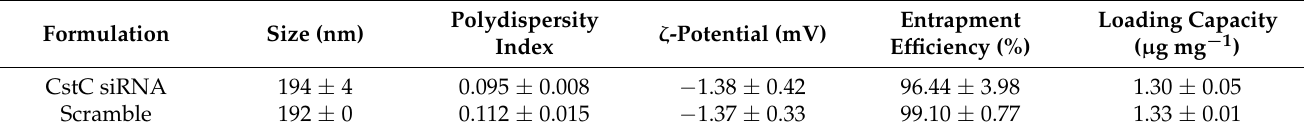
Table 1. Physicochemical characterization of the particle formulations.